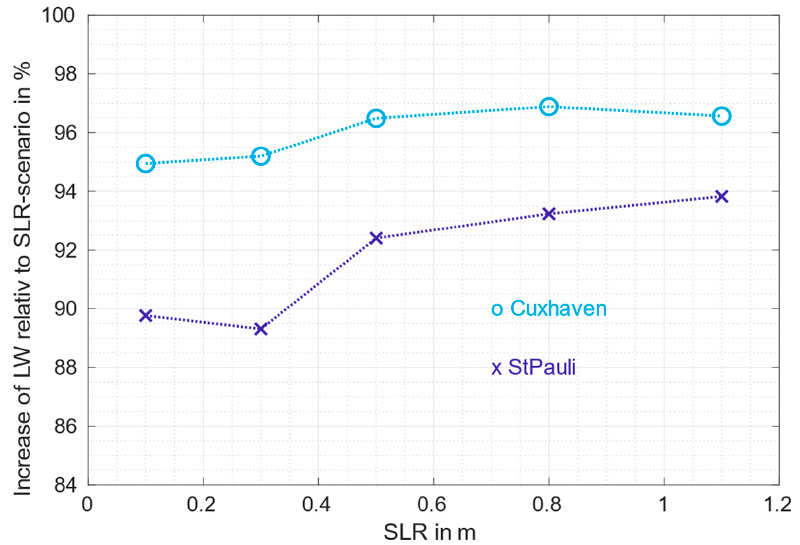
Figure 13. Simulation results: Increase of the lowest ELW in March 2018 relative to several sea level rise scenarios between 10 and 110 cm at Cuxhaven and St. Pauli.